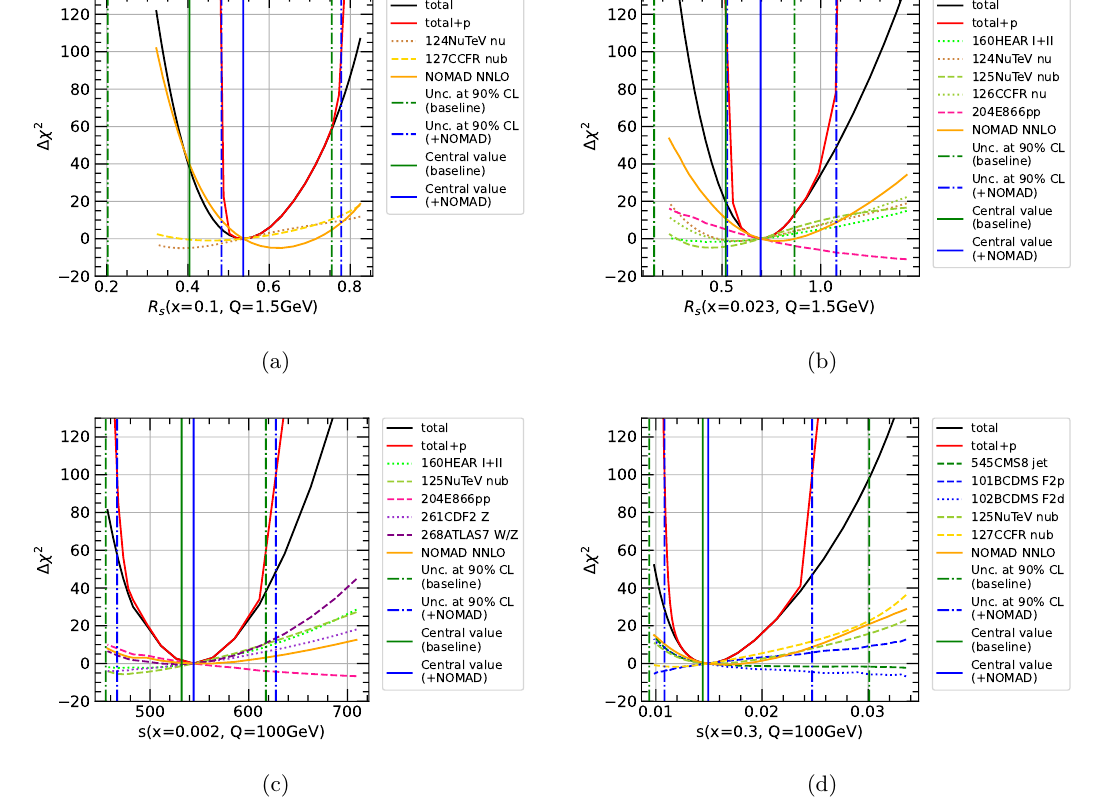
Figure 18 . LM scans on the R s at Q = 1 . 5 GeV and x = 0 . 1 or 0.023 (upper panels), and LM scans on the s -quark at Q = 100 GeV and x = 0 . 002 or 0.3 (lower panels). The blue and the green vertical solid (dot-dash) lines represent the central values (uncertainties) with and without NOMAD data